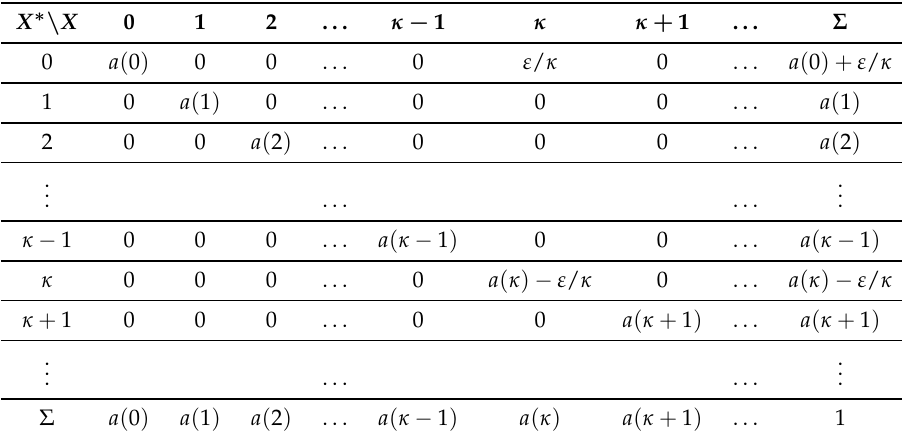
Table 4. Distribution of vector ( X , X ∗ )